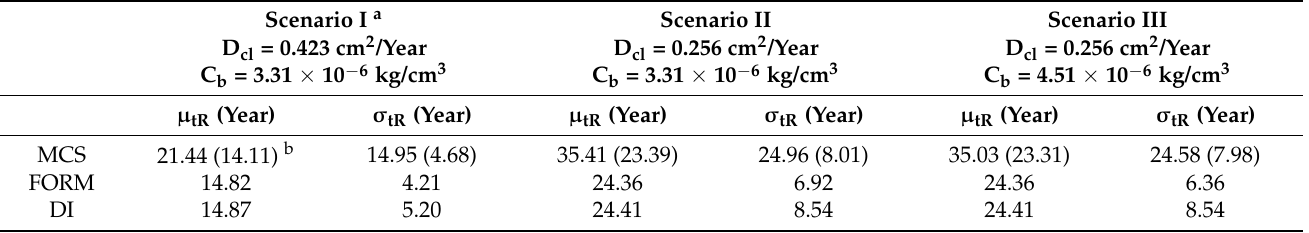
Table 3. Scenarios of the t R